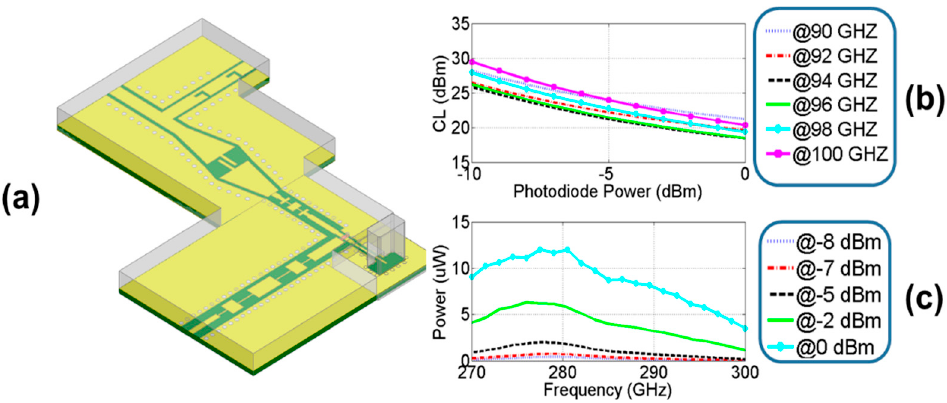
Figure 6. 3D perspective view of the complete tripler used for simulation and predicted response: Conversion loss (CL) and output power.